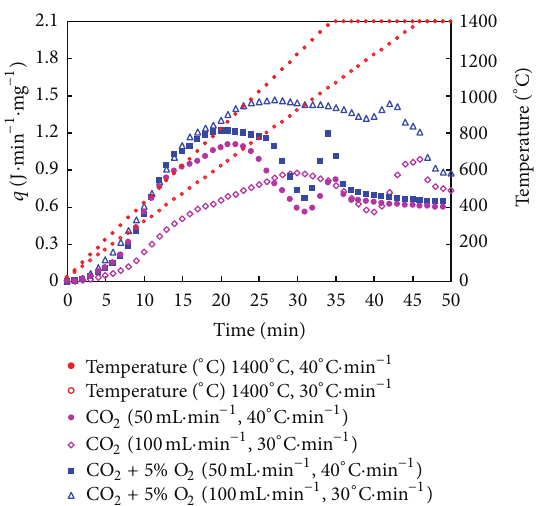
Figure 7: TG curves of coal under different temperature gradients. Figure8: DTAcurvesofcoalunderdifferenttemperaturegradients.